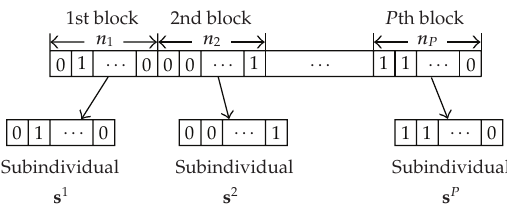
Figure 3: Division of an individual into P